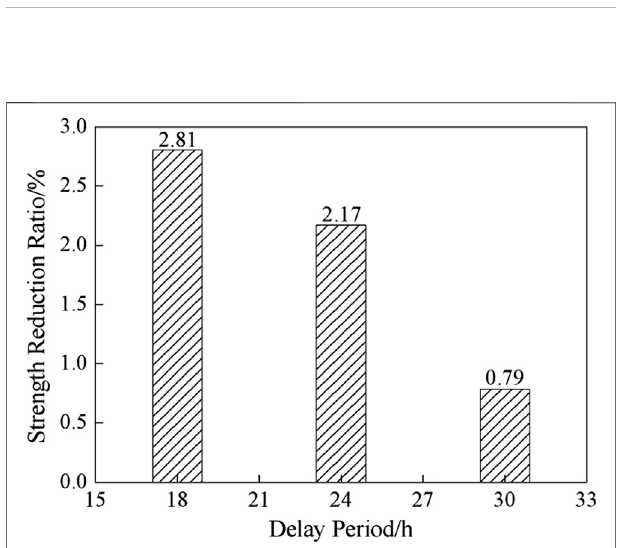
Figure 3 | Strength reduction ratio of RPC under different delay